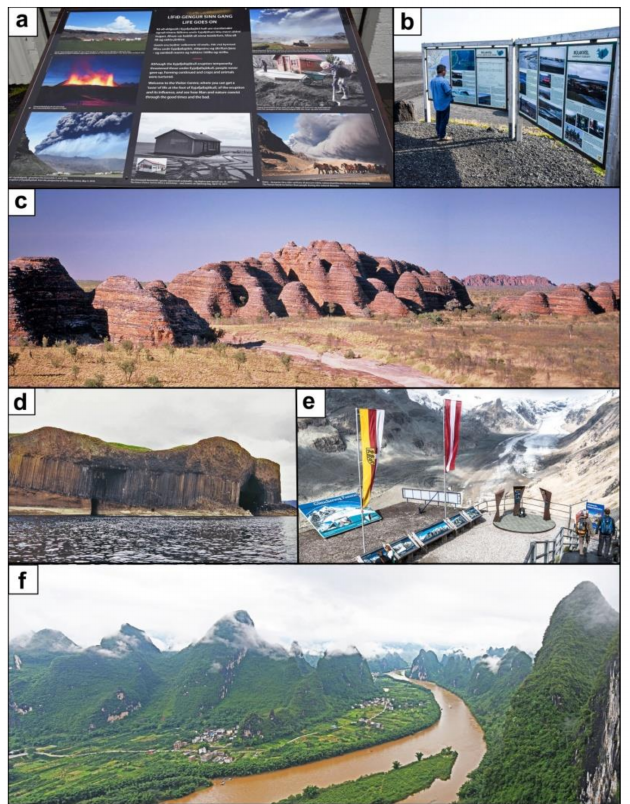
Figure 1. ( a ) Interpretation board at Eyafjallajökull Visitor Centre, Iceland, explains that “life goes on” after the volcanic eruption of April 2011. ( b ) Interpretation board at M ú lakv í sl, Iceland, explains the effects of the jökulhlaup in 2011, which destroyed a major bridge on the island’s main ring road. ( c ) The Bungle Bungle Range in Purnulu National Park and World Heritage Site, Australia, is becoming an increasingly popular tourist destination. It is an outstanding example of cone karst in Devonian sandstone, supports a diverse range of habitats, from deep, sheltered gorges to semi-arid plains, and has special spiritual and cultural significance for local Aboriginal clan groups. ( d ) The Palaeogene volcanic features at Fingal’s Cave, Staffa, Scotland, have been a tourist destination since the late 18th century and a source of inspiration for poetry music and art. ( e ) The retreat of the Pasterze Glacier, the largest glacier in Austria and the Eastern Alps, in the Hohe Tauern National Park, has increased in response to warmer summer temperatures and lower snowfall. A major tourist attraction, the Kaiser-Franz-Josefs-Höhe Visitor Centre offers panoramic views over the glacier and the Grossglockner massif, Austria’s highest mountain. Information boards and an educational glacier trail explain the glacial processes and history of retreat. ( f ) The spectacular karst landscape of Guilin and the River Li, China, is a World Heritage Site celebrated in poetry and painting for many centuries. Photos: John